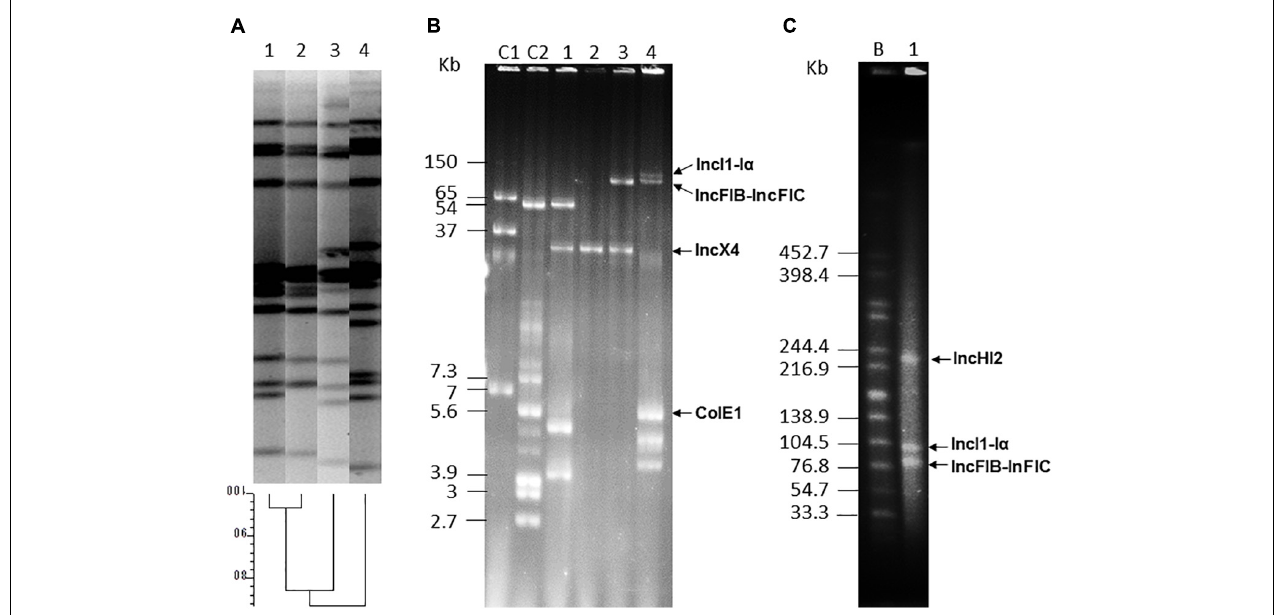
FIGURE 1 | Typing of food-borne isolates belonging to the European monophasic clone, and plasmid analysis. (A) XbaI-PFGE and dendrogram showing the similarity between the generated profiles. Lane 1, LSP 295/15; lane 2, LSP 298/15; lane 3, LSP 38/19; lane 4, LSP 237/15. (B) Plasmid profiles generated with the Kado-Liu method. Lanes C1 and C2, plasmids obtained from Escherichia coli 39R861 (NCTC 50192) and V517 (NCTC 50193) used as size standards for undigested DNA; lane 1, LSP 237/15; lane 2, LSP 295/15; lane 3, LSP 298/15; lane 4, LSP 38/19. (C) S1-PFGE. Lane B, XbaI-digested DNA of Salmonella enterica serovar Braenderup H9812 used as size standard; lane 1, LSP 38/19. Resistance plasmids are indicated in (B,C) .